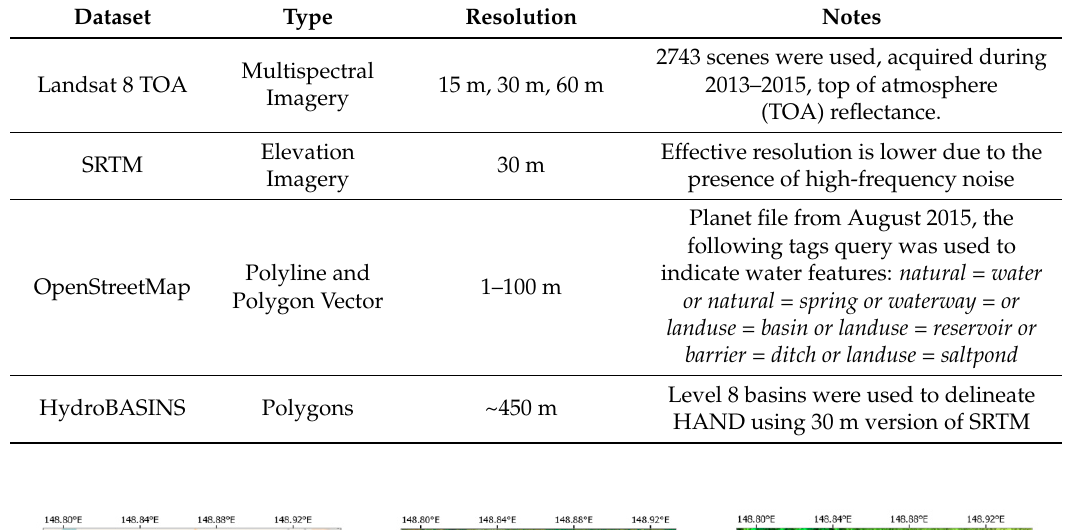
Table 1. Input datasets used in the study.